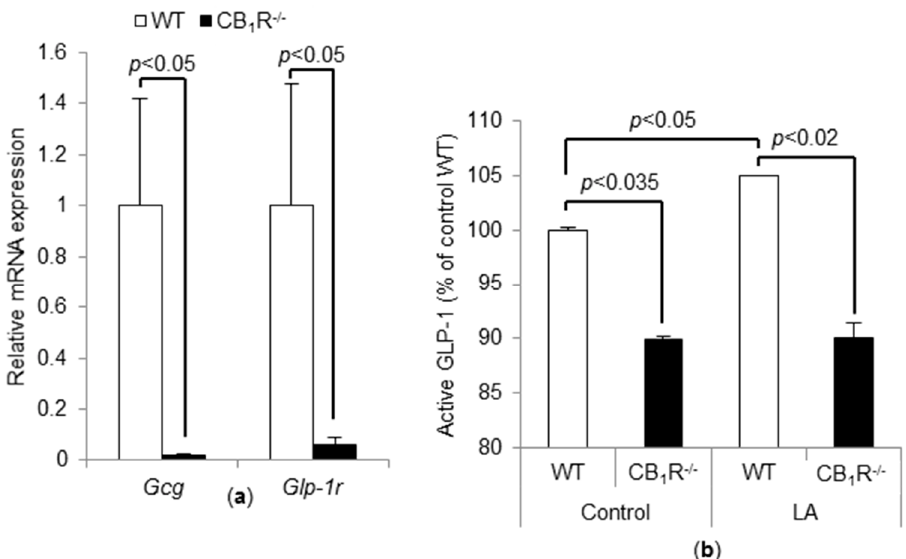
Figure 4. Effect of CB 1 R gene invalidation on GLP-1. ( a ) Proglucagon (Gcg) and GLP-1r mRNA levels were assayed by real-time qPCR in mouse TBC from WT and CB 1 R − / − mice. Values are expressed as mean ± SEM ( n = 6). ( b ) ELISA results showing GLP-1 release by freshly isolated mouse TBC incubated for 2 h in the presence of 33 µ M fatty acid-free BSA alone (CTRL) or with 200 µ M linoleic acid (LA). Each value corresponds to the GLP-1 released by cultured TBC. We independently reproduced the results twice, by using, each time, TBC from three mice. We observed identical results, and we pooled them. Each point represents values as mean ± SD ( n = 6).